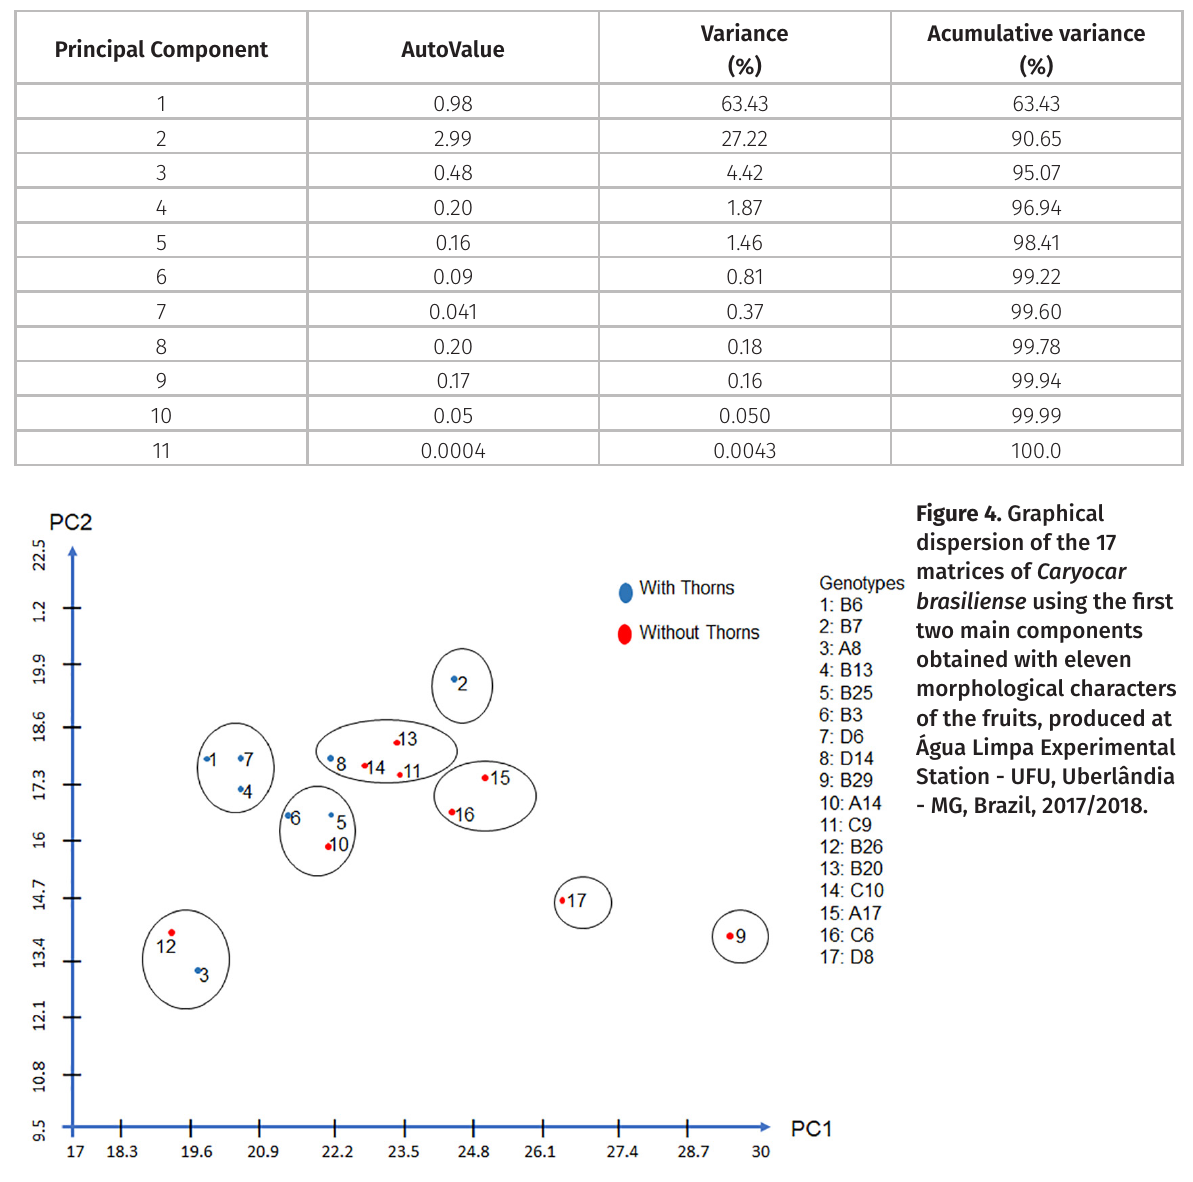
Figure 4. Graphical dispersion of the 17 matrices of Caryocar brasiliense using the first two main components obtained with eleven morphological characters of the fruits, produced at Água Limpa Experimental Station - UFU, Uberlândia - MG, Brazil,